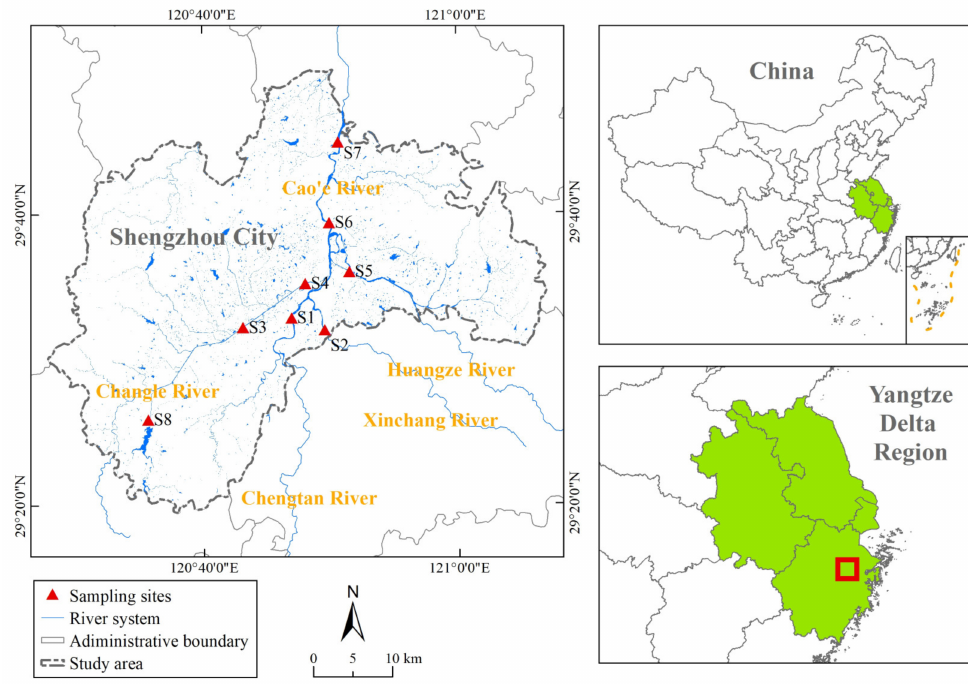
Figure 1. Location of the study area and sampling